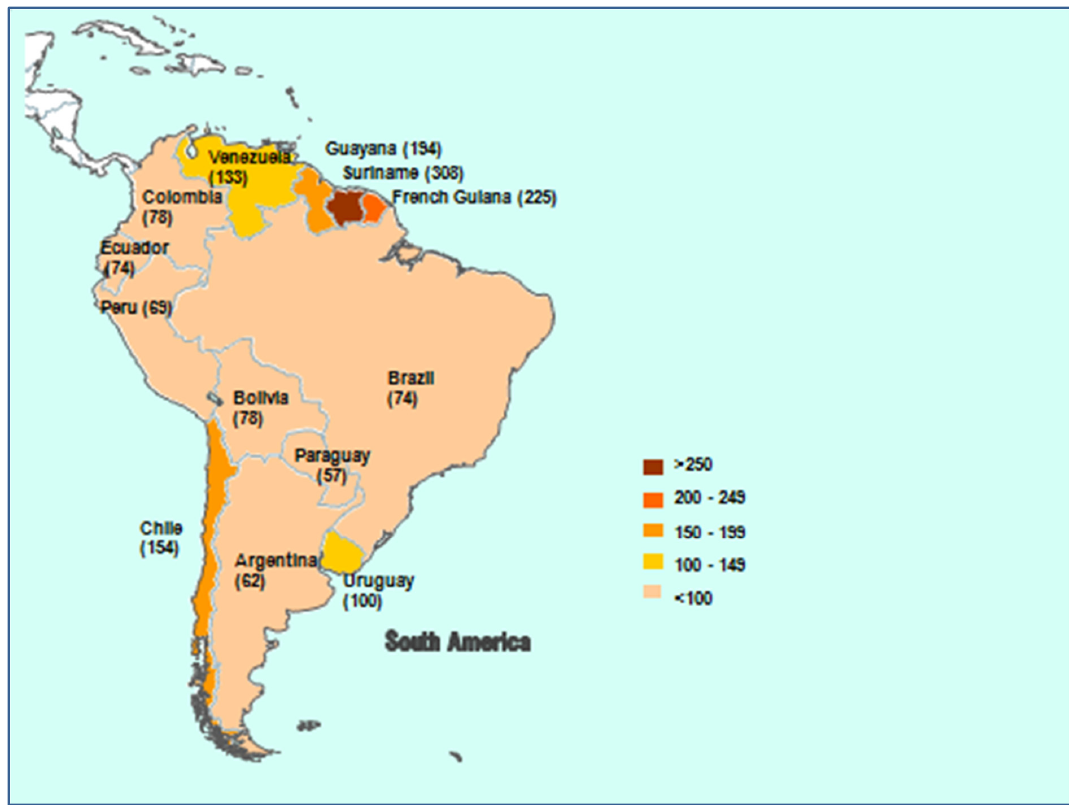
Figure 1: Incarceration rates, South America, 1992 11